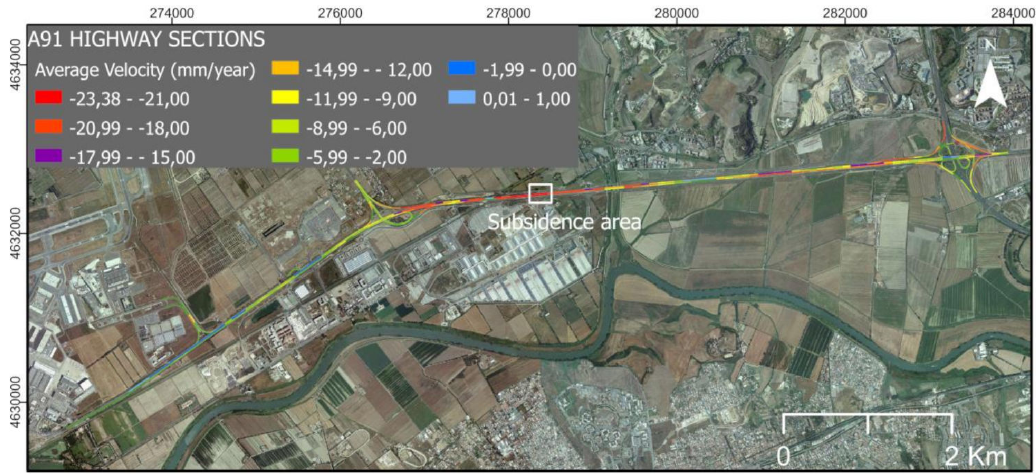
Figure 14. Map of sections of the A91 highway, classified by average velocity entity, as background orthophoto